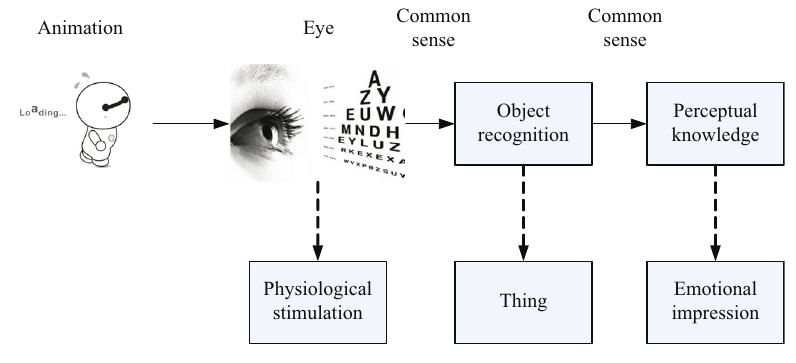
Figure 5: Visual cognitive process of pictures.